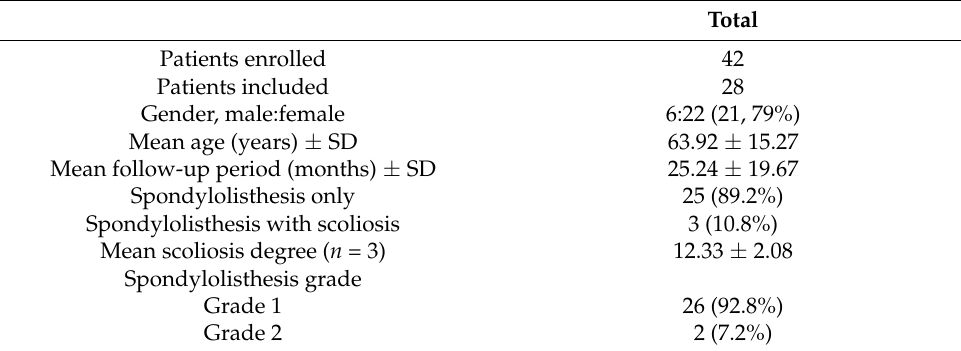
Table 1. Demographic characteristics and clinical data.